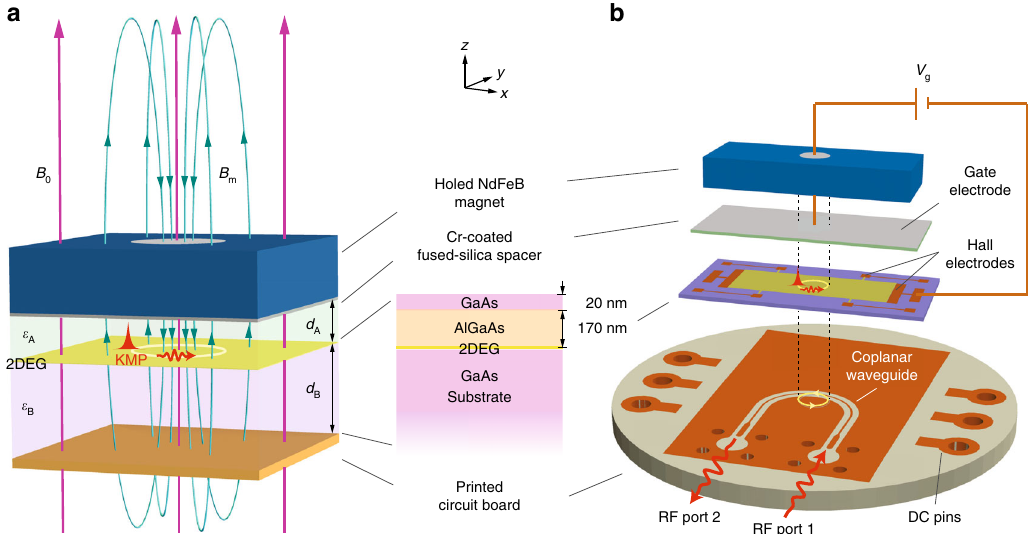
Fig. 1 Topological magnetoplasmonic device. a Conceptual layout. b Device design and PCB layout. The 2DEG is formed at the interface of a GaAs/AlGaAs heterojunction, cladded between a fused-silica spacer and the substrate, and fi nally enclosed in a metallic cavity. A holed NdFeB magnet on the top provides an oppositely signed magnetic fi eld at the 2DEG to permit kink magnetoplasmons (KMPs) traveling unidirectionally along the magnetic-domain boundary. Microwaves transmitted along the coplanar waveguide on a printed circuit board excite the KMPs. An applied uniform magnetic fi eld B 0 or a gate voltage V g can tune the